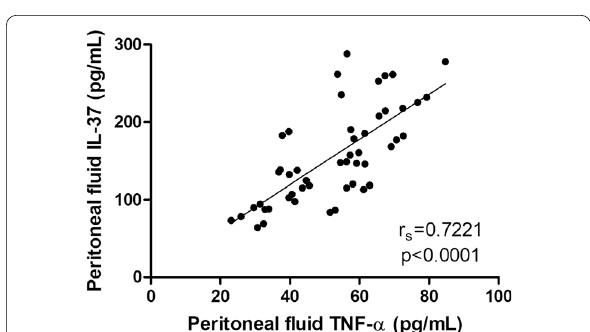
Fig. 5 Levels of IL-37 in peritoneal fluid of endometriosis patients positively correlated with TNF-α